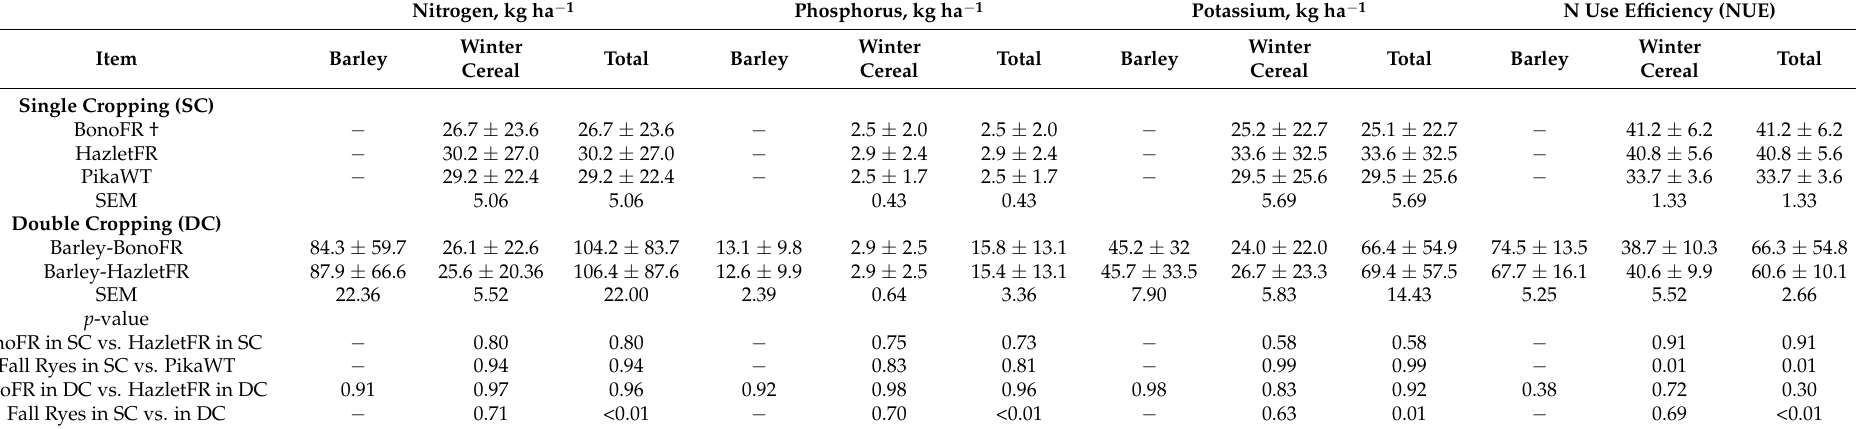
Table 8. Mineral uptake and nitrogen use efficiency (means ± SD) of whole-crop winter cereals in single and double cropping